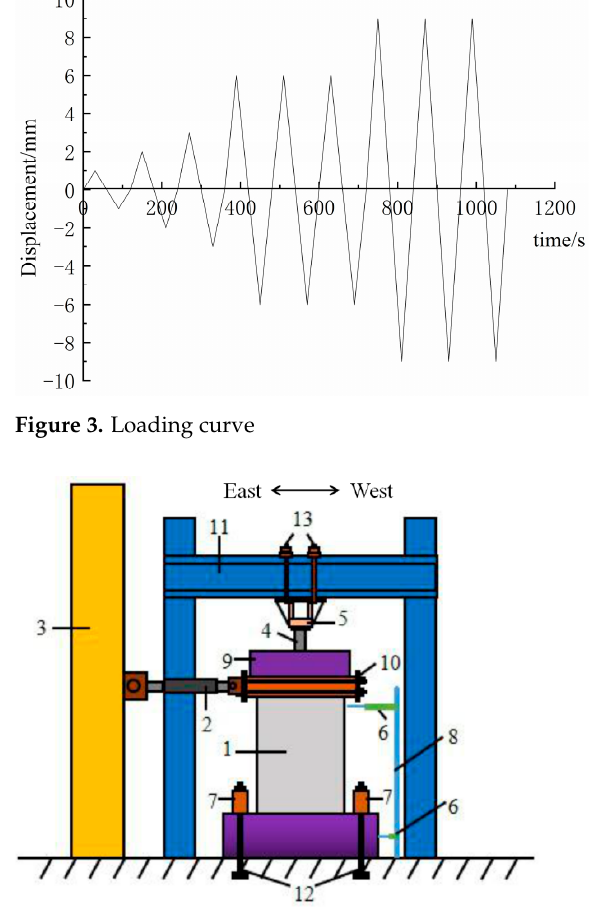
Figure 4. Loading device. Notes: 1. Wall panel specimens; 2. Actuator; 3. Reaction wall; 4. Hydraulic jack; 5. Sensor; 6. Displacement gauge; 7. Reaction beam; 8. Upright stanchion; 9. Rigid strut beam; 10. The pull rod connection device; 11. Positive electrode method; 12. Anchor bolt; 13. Set bolt.